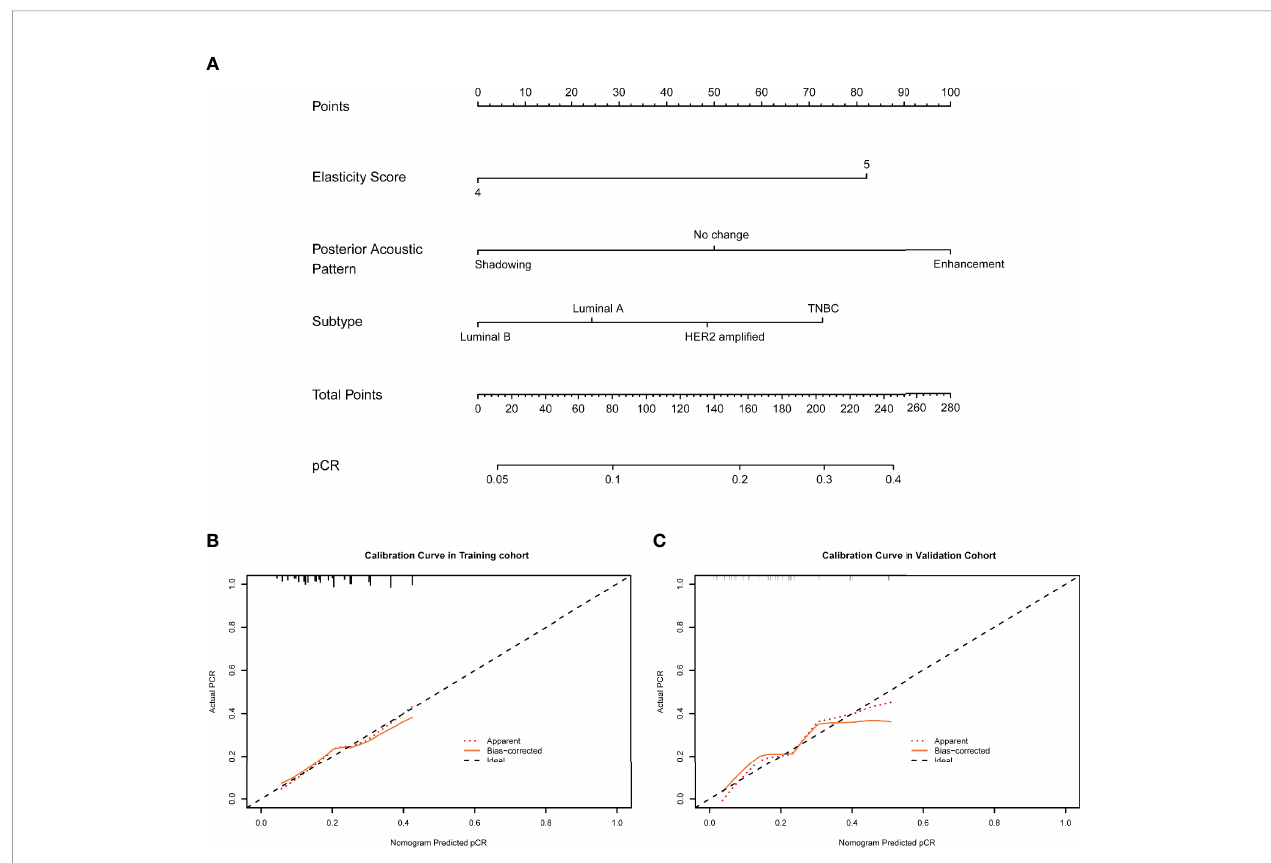
FIGURE 3 | (A) An initial-baseline nomogram was constructed from three informative features ( Table 2 ). To calculate the probability of patients achieving pCR after NAC, points for each parameter were assigned by corresponding values from the “ points ” axis, and the sum of the points was plotted on the “ total points ” axis. The probability of achieving pCR after NAC was the value at a vertical line from the corresponding total points (B, C) . pCR, pathological complete response; NAC, neoadjuvant